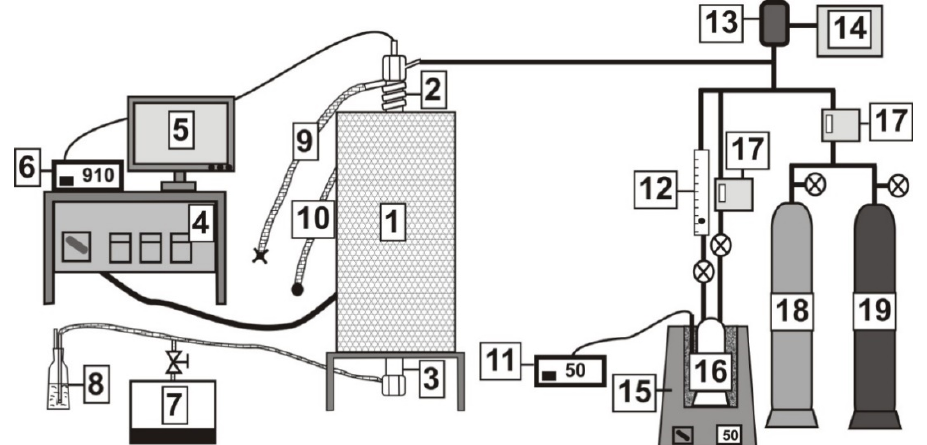
Figure 1. The scheme of devices used for simultaneous gas borocarburizing in N 2 –H 2 –B(CH 3 O) 3